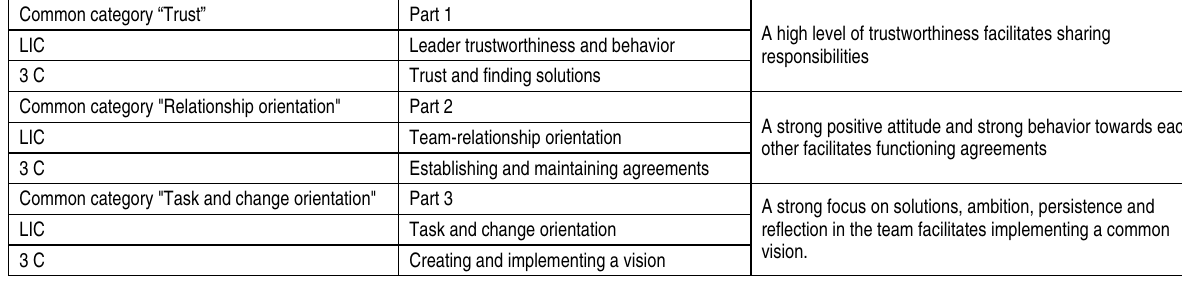
Table 1. Common categories in the 3C and LIC